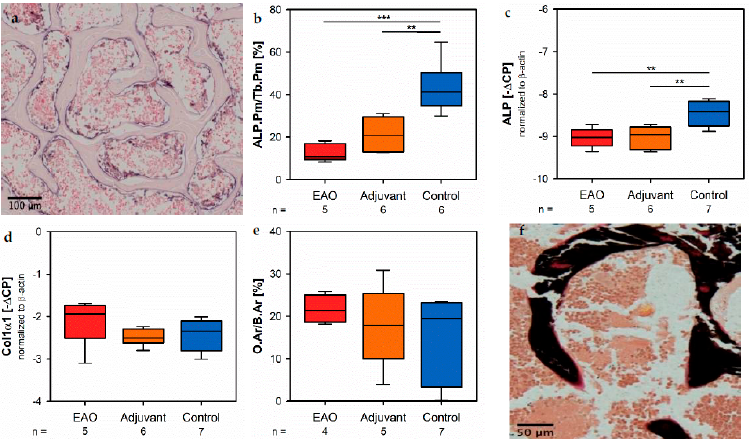
Figure 9. Osteoblasts. ( a ) Enzyme histochemical staining of alkaline phosphatase (ALP, violet) in vertebral body L3 from an untreated mouse. ( b ) Histomorphometrical calculation of relative ALP perimeter (ALP.Pm/Tb.Pm) in enzyme histochemical-stained vertebral bodies L3. mRNA expression of ( c ) ALP and ( d ) collagen 1 α 1 (Col1 α 1) in real-time RT-PCR of vertebral bodies Th10. ( e ) Histomorphometrical calculation of relative osteoid area (O.Ar/B.Ar) in vertebral bodies L2 by Von Kossa/Van Gieson staining. ( f ) Von Kossa/Van Gieson staining in vertebral body L2 from an untreated mouse (red: osteoid; black: mineralized bone; brown: bone marrow). Mice were immunized with testicular homogenate in adjuvant (EAO), adjuvant alone (adjuvant) or remained untreated (control). ** p < 0.01; *** p < 0.001. 2.5. Osteoclasts Osteoclasts were identified by enzyme histochemical staining of tartrate resistant acid phosphatase (TRAP). Multinuclear, red stained cells in contact to the trabecular sur- face were counted as osteoclasts (Figure 10a). The calculation of osteoclast number in re- lation to trabecular perimeter (TRAP.N/Tb.Pm, Figure 10b) illustrated a significant reduc- tion of osteoclasts in EAO (1.924 ± 0.488 n/mm) and adjuvant groups (1.933 ± 0.407 n/mm) compared to control (5.447 ± 0.527 n/mm, p < 0.001 each). These findings were supple- mented by the results of real-time RT-PCR regarding cathepsin K (CtsK), another typical degrading enzyme of osteoclasts. The mRNA expression of cathepsin K (Figure 10c) was significantly decreased after EAO ( − 4.522 ± 0.292 [ −∆ CP]) in comparison to control ( − 3.754 ± 0.159 [ −∆ CP], p < 0.05) while it was not significantly decreased in the adjuvant group ( − 4.097 ± 0.129 [ −∆ CP], p = 0.620). As a major regulatory factor of osteoclast differentiation, we determined the mRNA expression of the receptor activator of nuclear factor-kappa B ligand (RANKL, Figure 10d) but no significant alterations were detected (EAO − 11.292 ± 0.088 [ −∆ CP], Adj − 11.192 ± 0.085 [ −∆ CP], Cont − 10.816 ± 0.237 [ −∆ CP]). Additionally, we evaluated the mRNA expression of osteoprotegerin (OPG, Figure 10e), an inhibitor of RANKL and, thereby, regulating the differentiation of osteoclasts. Expression of osteoprotegerin was significantly reduced in the adjuvant group ( − 10.530 ± 0.186 [ −∆ CP], p < 0.01 vs. Cont − 9.493 ± 0.194 [ −∆ CP]) and almost significantly decreased after EAO ( − 10.262 ± 0.249 [ −∆ CP], p = 0.062 vs. Cont). Therefore, the reduction of osteoclast activity can neither been explained by RANKL nor by osteoprotegerin. Detailed results are shown in Table S7.